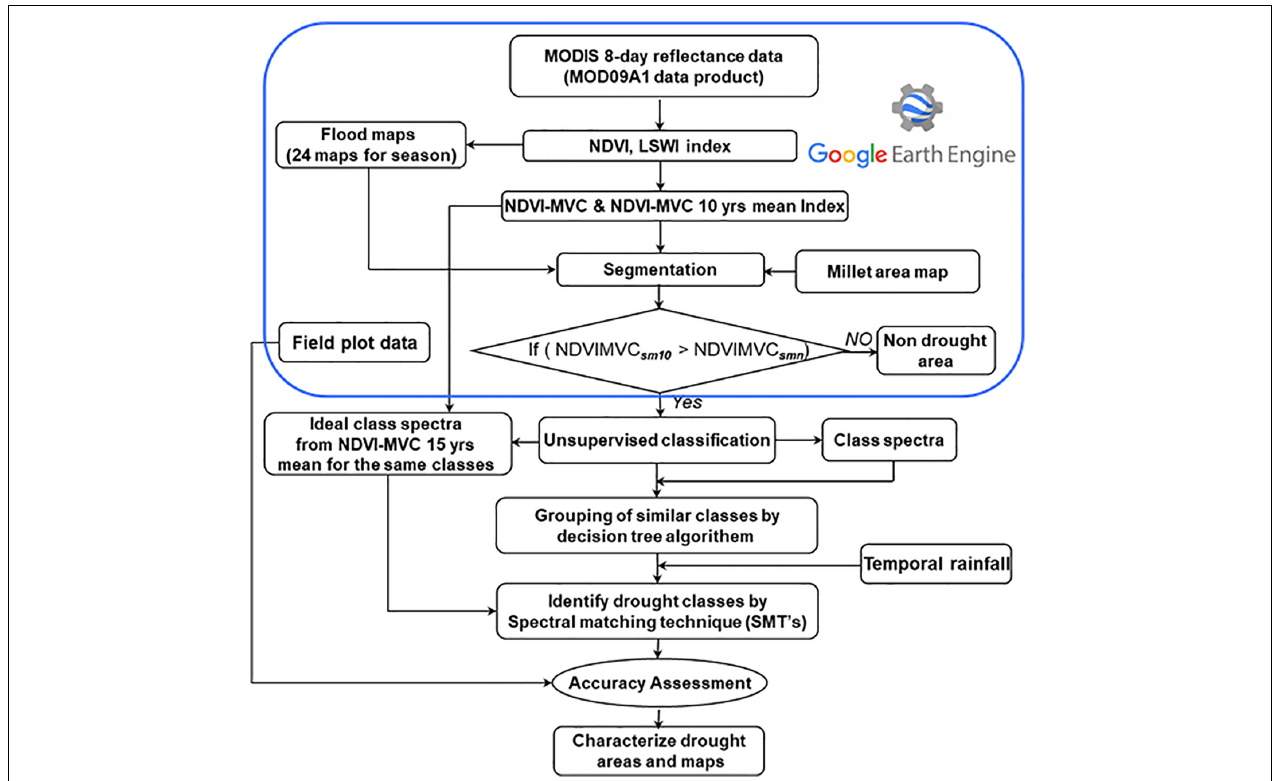
FIGURE 5 | Flow diagram for drought characterization using spectral matching